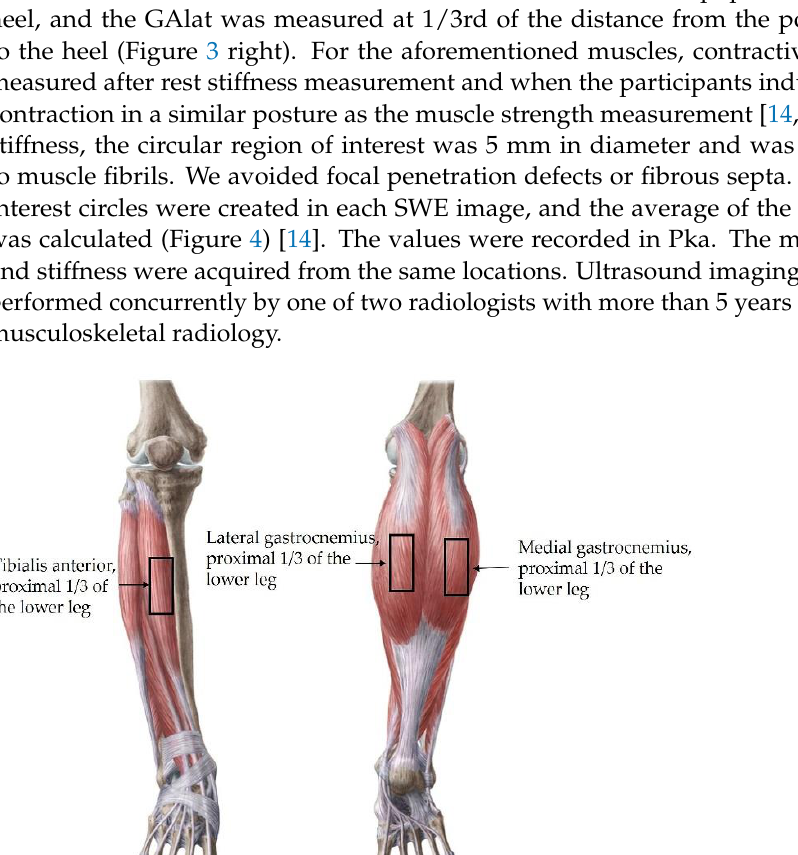
Figure 2. The muscle thickness was measured maximum distance between the fascia.